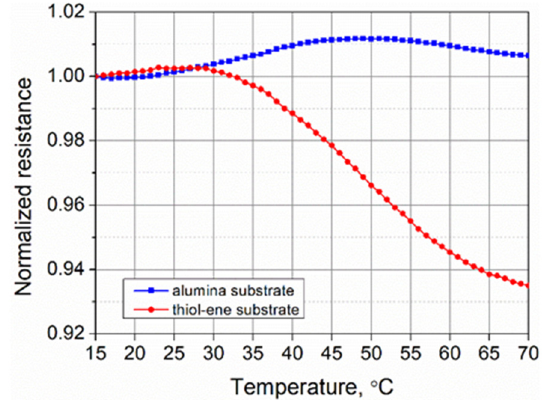
Figure 12. Normalized resistance of PEDOT:PSS films on alumina and thiol–ene substrates versus temperature.